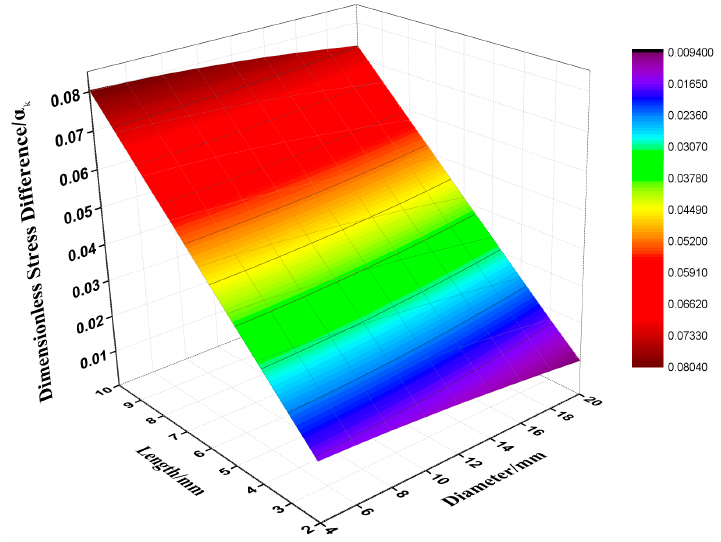
Figure 3. The size of the specimen corresponding to the dimensionless stress difference.